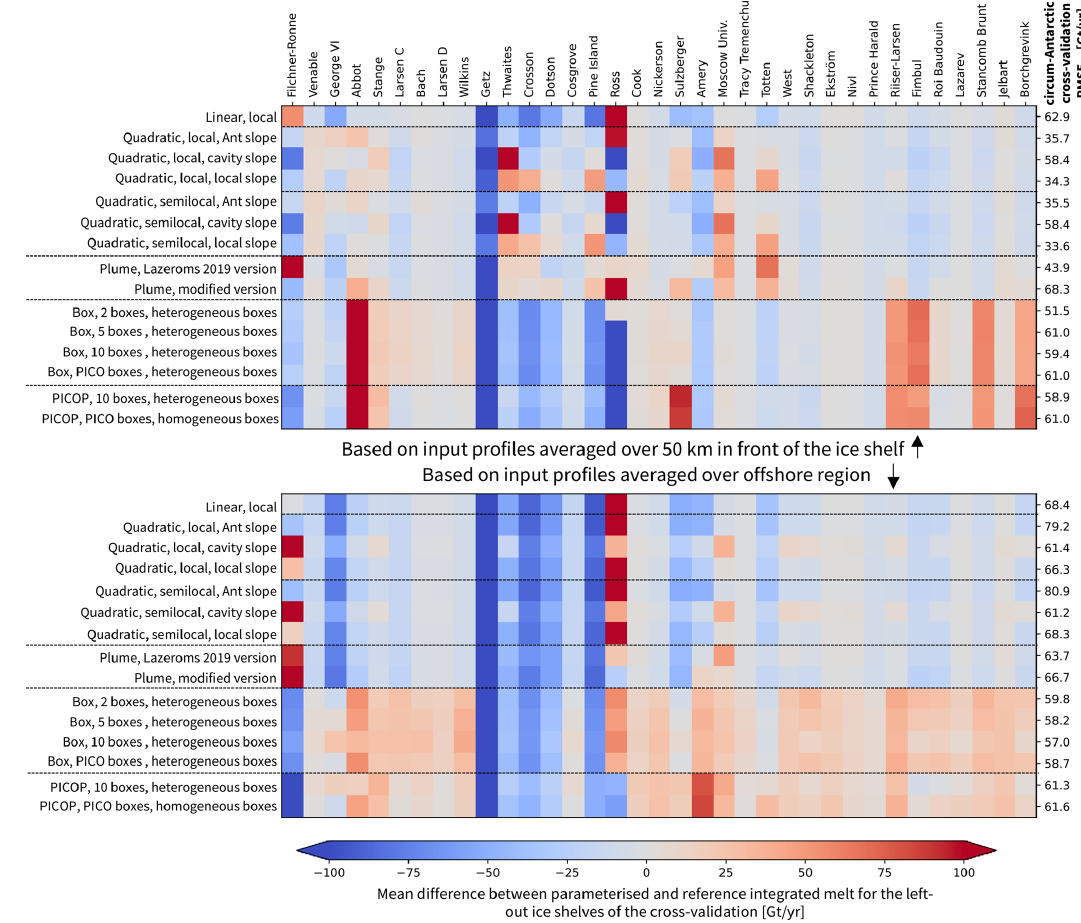
Figure E2. Mean difference between parameterised and reference integrated ice-shelf melt for the synthetically independent evaluation dataset for the cross-validation over ice shelves. The average is taken over yearly averages across all four simulations (127 years in total). The values on the right are the RMSE int for the cross-validation over ice shelves shown in Fig. 4. Results are shown for the 50km (upper panel) and the offshore (lower panel) domains. “Ant slope” stands for “Antarctic